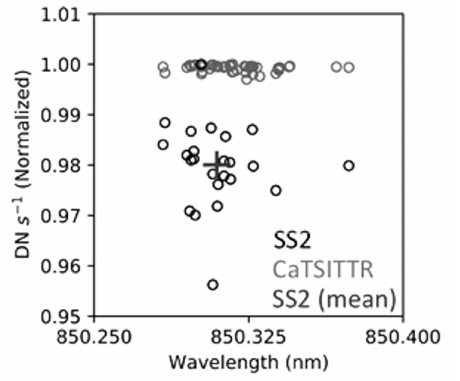
Figure 18. Comparison of relative Digital Numbers (DNs) between the multispectral system (labeled CaTSSITTR; more details about the instrument are provided in Section 5.3) and the SOLARIS data (labeled SS2) for a single GLAMR-tuned wavelength. The mean values of the SOLARIS data are shown by the +